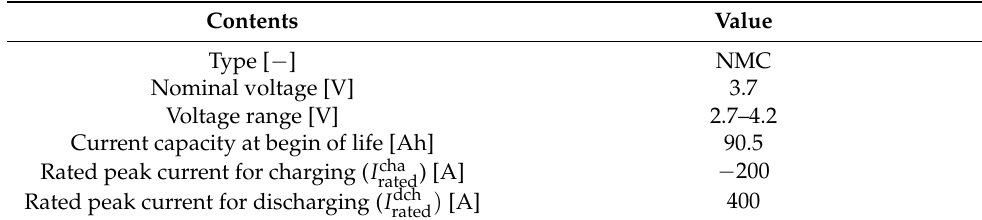
Table 2. Specifications of the battery cell in the tested pack.